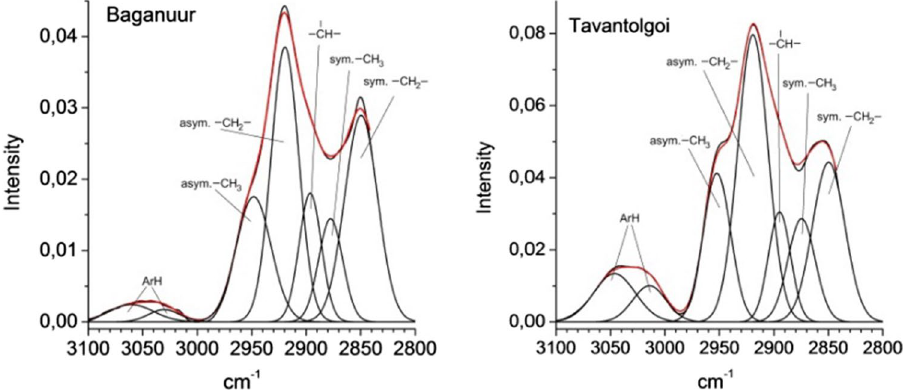
Fig. 3 The deconvoluted FTIR spectra for Baganuur and Tavan- tolgoi coals as